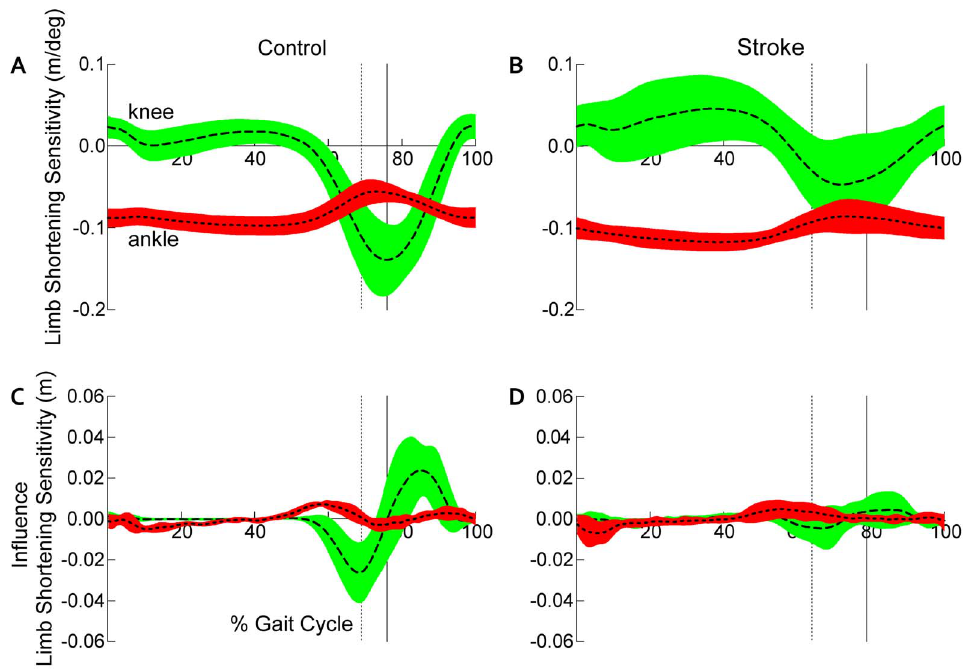
Figure 3. Contributions to paretic limb shortening. Limb shortening sensitivity, normalized to the gait cycle, for (a) healthy controls and (b) participants post-stroke. Limb shortening sensitivity - defined as the partial derivative of limb shortening with respect to sagittal plane knee and ankle angles. Negative values of limb shortening sensitivity indicate a positive rotation at a given joint decreases the normalized limb length, thus increasing limb shortening. Note, the timing of sensitivity peaks differs between groups (Table 1). To eliminate the direction of joint motion from the interpretation of each joint’s contribution to limb shortening, we illustrate the estimated influence of each joint, normalized to the gait cycle, for (c) healthy controls and (d) participants post-stroke. Vertical cursors represent toe off (dashed) and maximal limb shortening (solid). Knee and ankle curves are depicted as dashed and dotted lines, respectively. Error clouds denote 6 1 standard deviation.